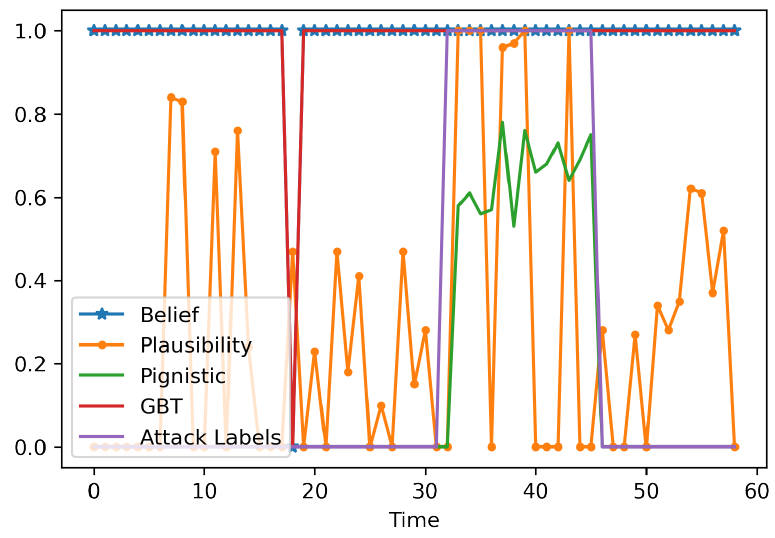
Figure 4. Decision criteria after distinctive fusion, with the probability scores from DT classifiers for Use Case